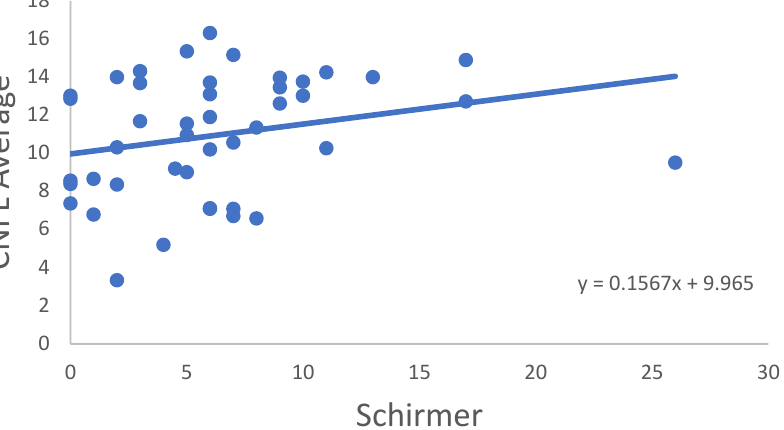
Figure 4. Correlation of CNFD Highest and Schirmer’s-test results.